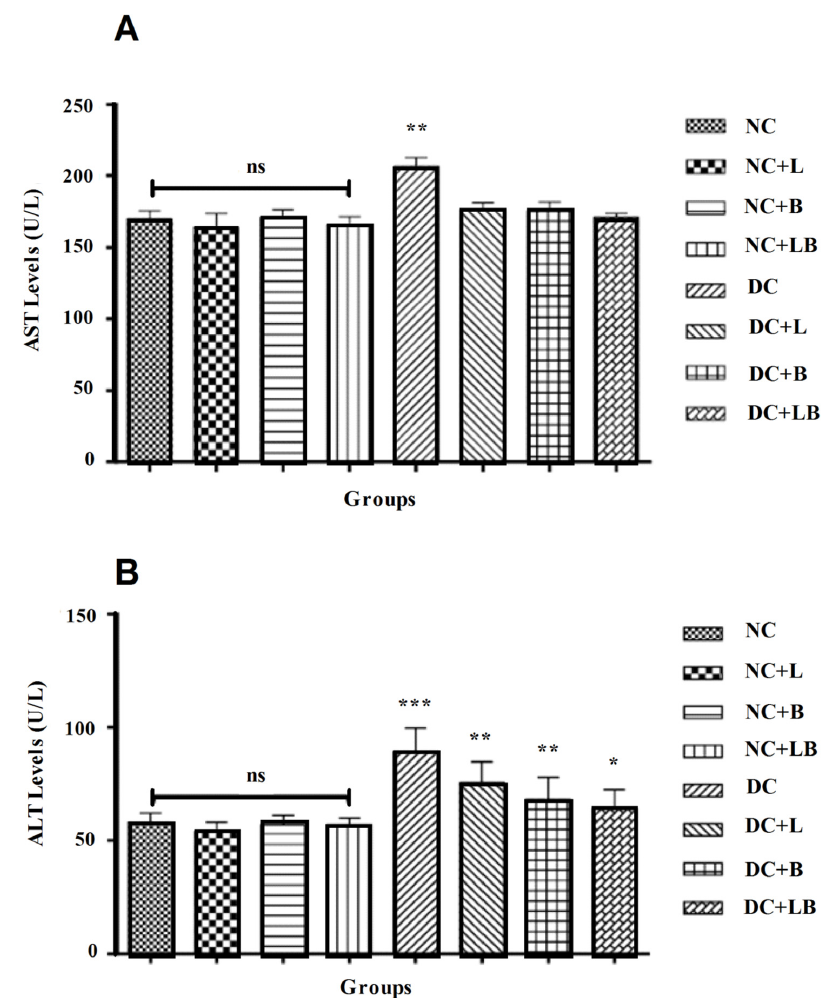
Figure 2. Impact of the daily administration of leaf and bud extracts and their combination on AST ( A ) and ALT ( B ) levels of different groups. Data are presented as mean ± SD; (*) comparison between the normal control group (NC) and all remaining groups. (The significance started at: * p < 0.05; ** p < 0.01; *** p < 0.001).